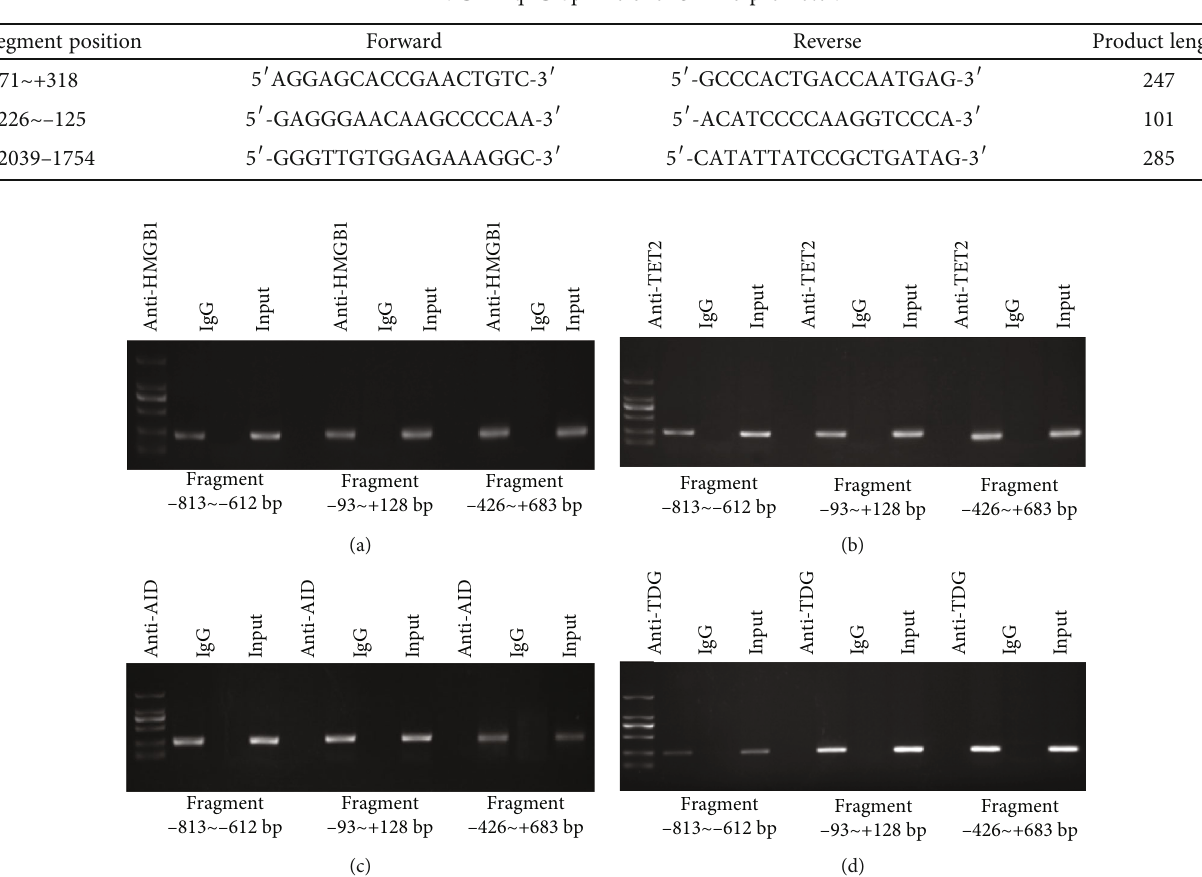
Table 2: ChIP-qPCR primers for STAT3 promoter.